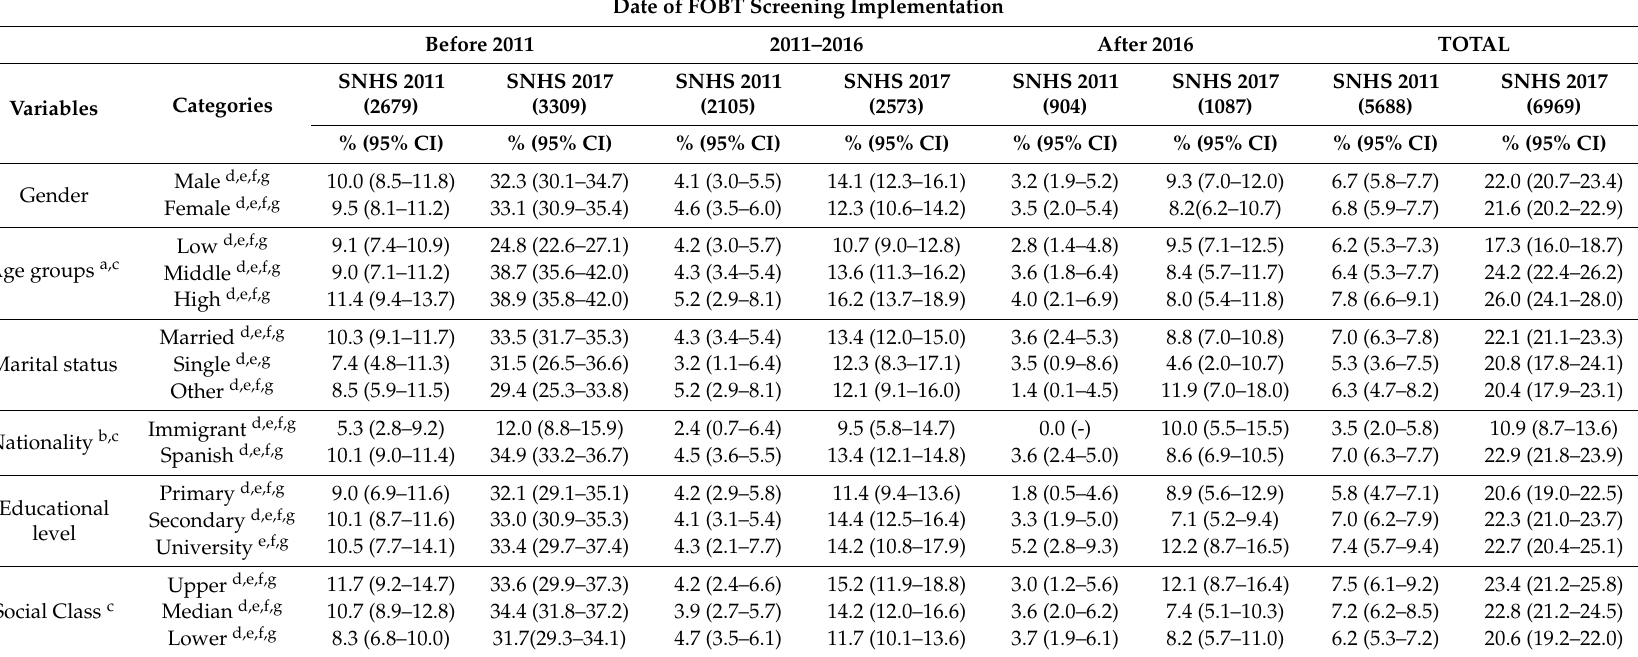
Table 3. Uptake for the FOBT in the past two years among the target population by sociodemographic variables and according to the implementation date. Results from the Spanish National Health Surveys 2011 and